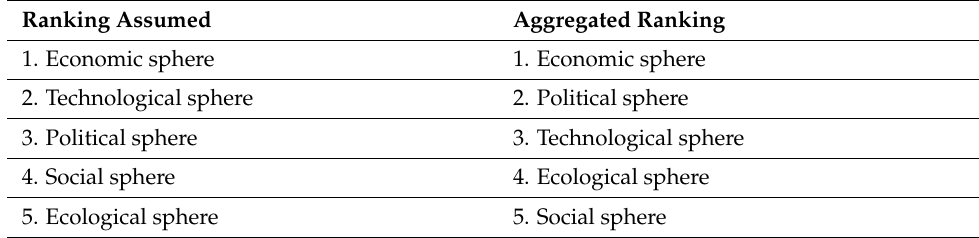
Figure 7. Need fulfillment degrees based on the expert opinions of RES experts. Source: own study. Color markings as in Figure 3. Table 8. Ranking of the ETPSE